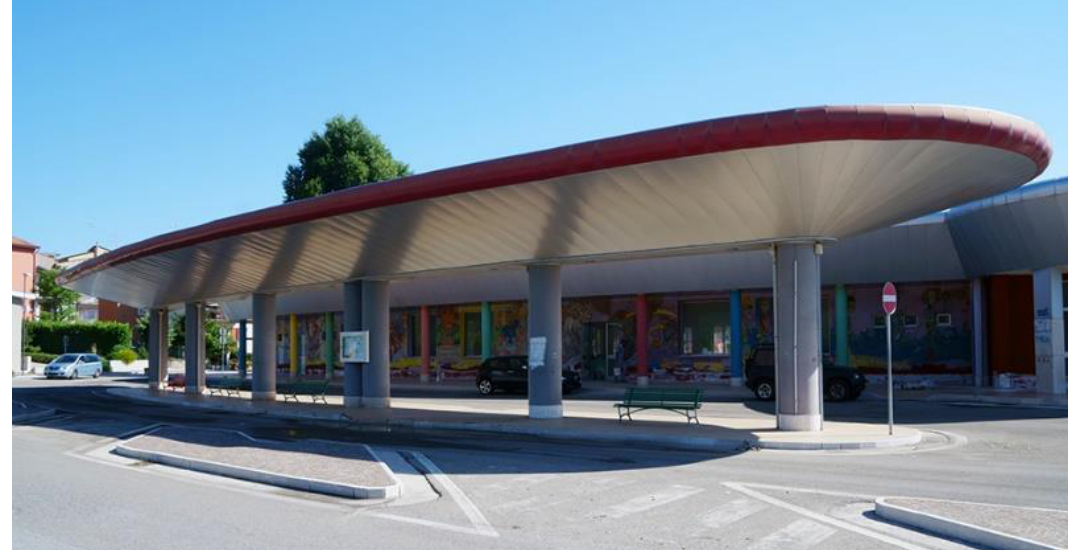
Figure 26. Lioni: modern bus station (photos by [35,36]).